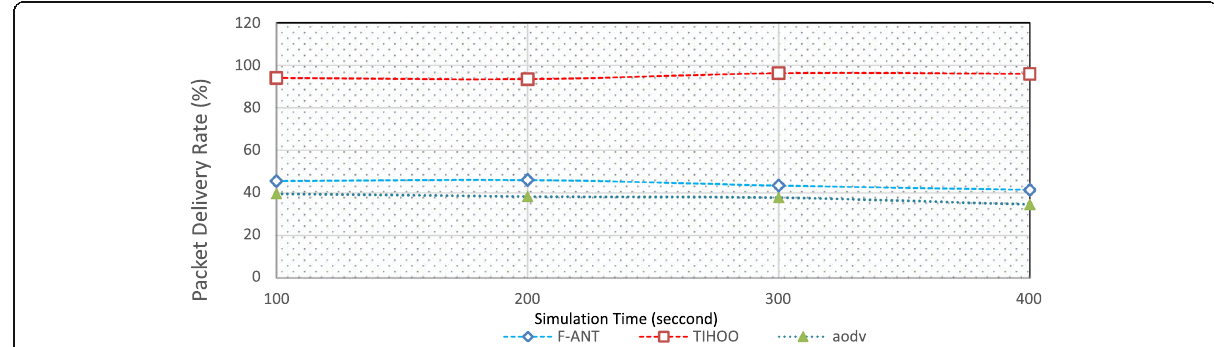
Fig. 11 Packet delivery ratio based on simulation time. The simulation results for packet delivery rate are assessed in this section based on the simulation time. The bigger rate of packet delivery in TIHOO is associated with the movement of packets in the most stable route which in turn is determined thanks to the application of stability factors in the fitness function of TIHOO. In addition, accounting for the available buffer for the selection of a less congested route is very effective in enhancing the number of delivered data packets